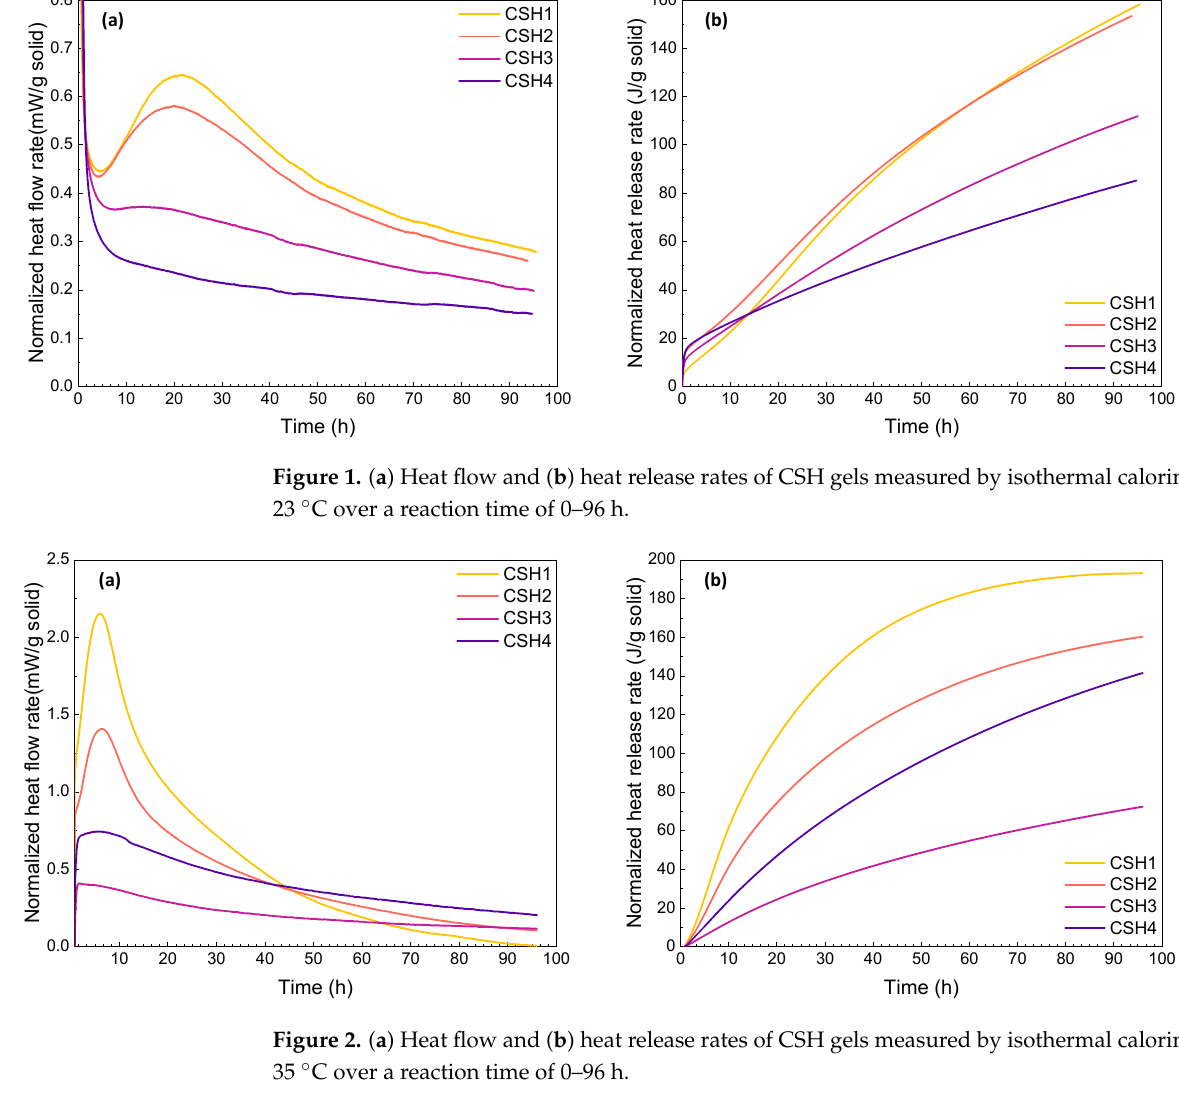
Figure 1. ( a ) Heat flow and ( b ) heat release rates of CSH gels measured by isothermal calorimetry at 23 °C over a reaction time of 0–96 h.